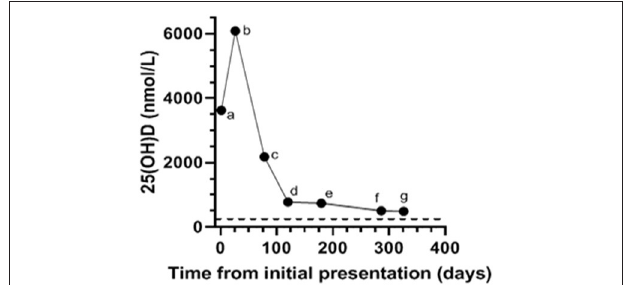
FIGURE 1 | Serial serum 25-hydroxyvitamin (OH)-D concentrations in a dog with cholecalciferol rodenticide toxicosis starting at the time of initial presentation (a; Day 1) as well as on subsequent evaluations on (b; Day 26, c; Day 78, d; Day 120, e; Day 179, f; Day 286, g; Day 326). The dog received prednisone (0.6 mg/kg PO q24h), aluminum hydroxide (16 mg/kg PO q12h), and Hills Prescription Diet k/d (Hill’s Pet Nutrition Inc., Topeka, KS) from